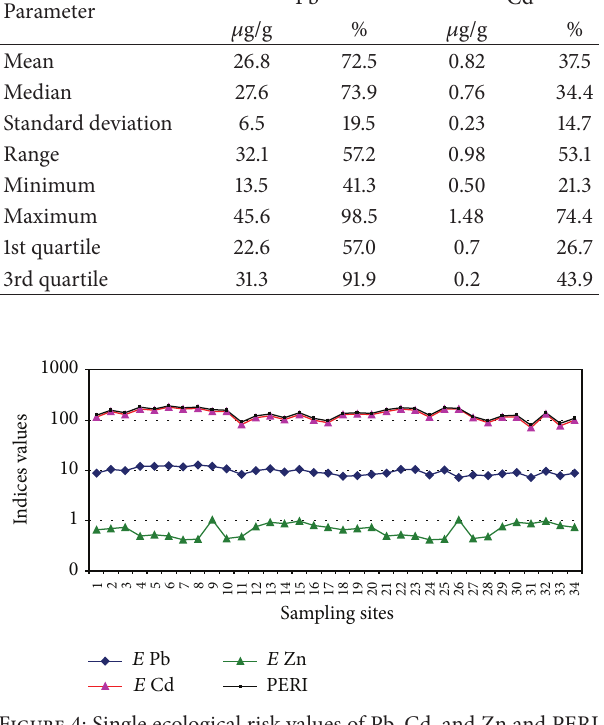
Figure 4: Single ecological risk values of Pb, Cd, and Zn and PERI in the studied soil samples.